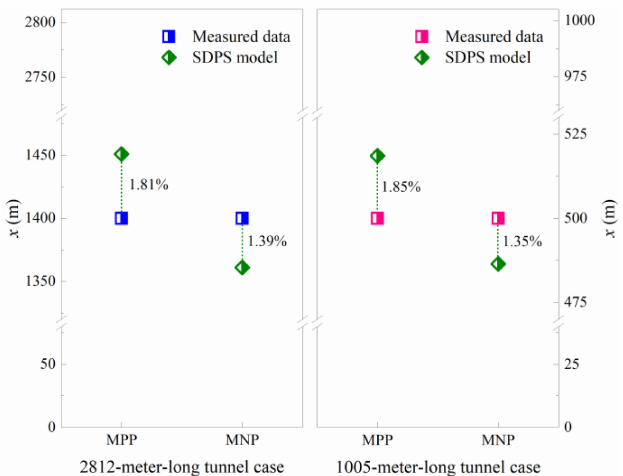
Figure 7. Comparison between the proposed SDPS model and field tests in two tunnels (MPP: maximum positive pressure, MNP: maximum negative